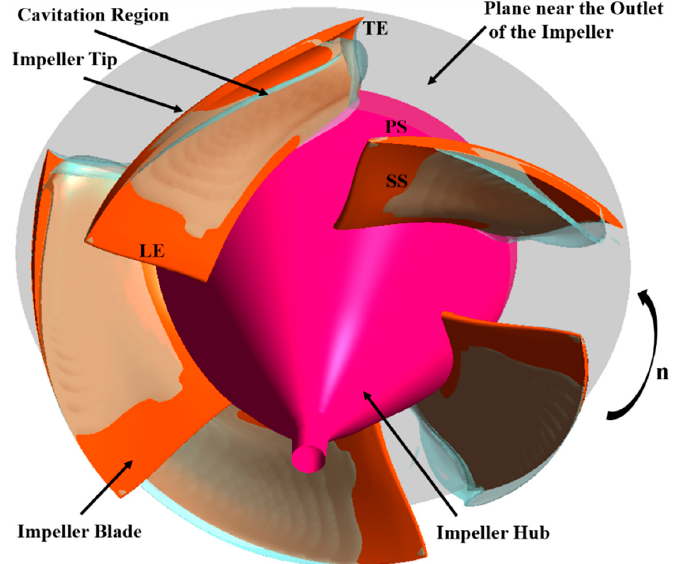
Figure 13. Plane selection and setting.